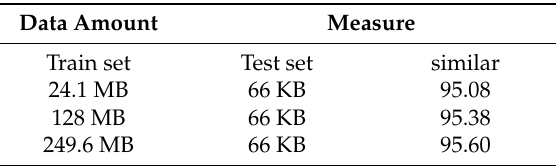
Table 8. Similarity of the string character.